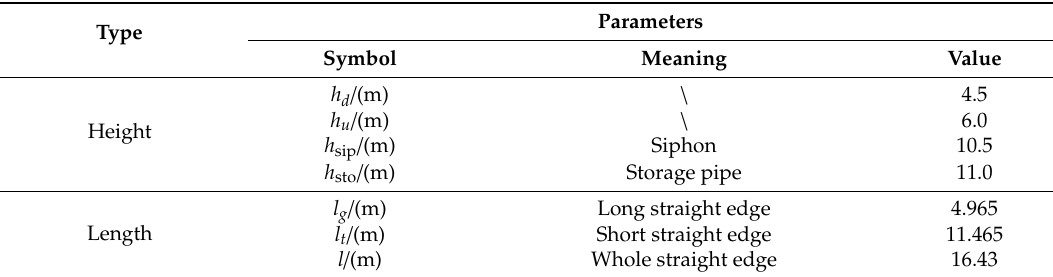
Figure 11. Flow chart of the simplified optimization algorithm used to select the optimum model and optimal height combination ( h d , h u ). Table 3. Main dimension parameters of the hydro energy conversion